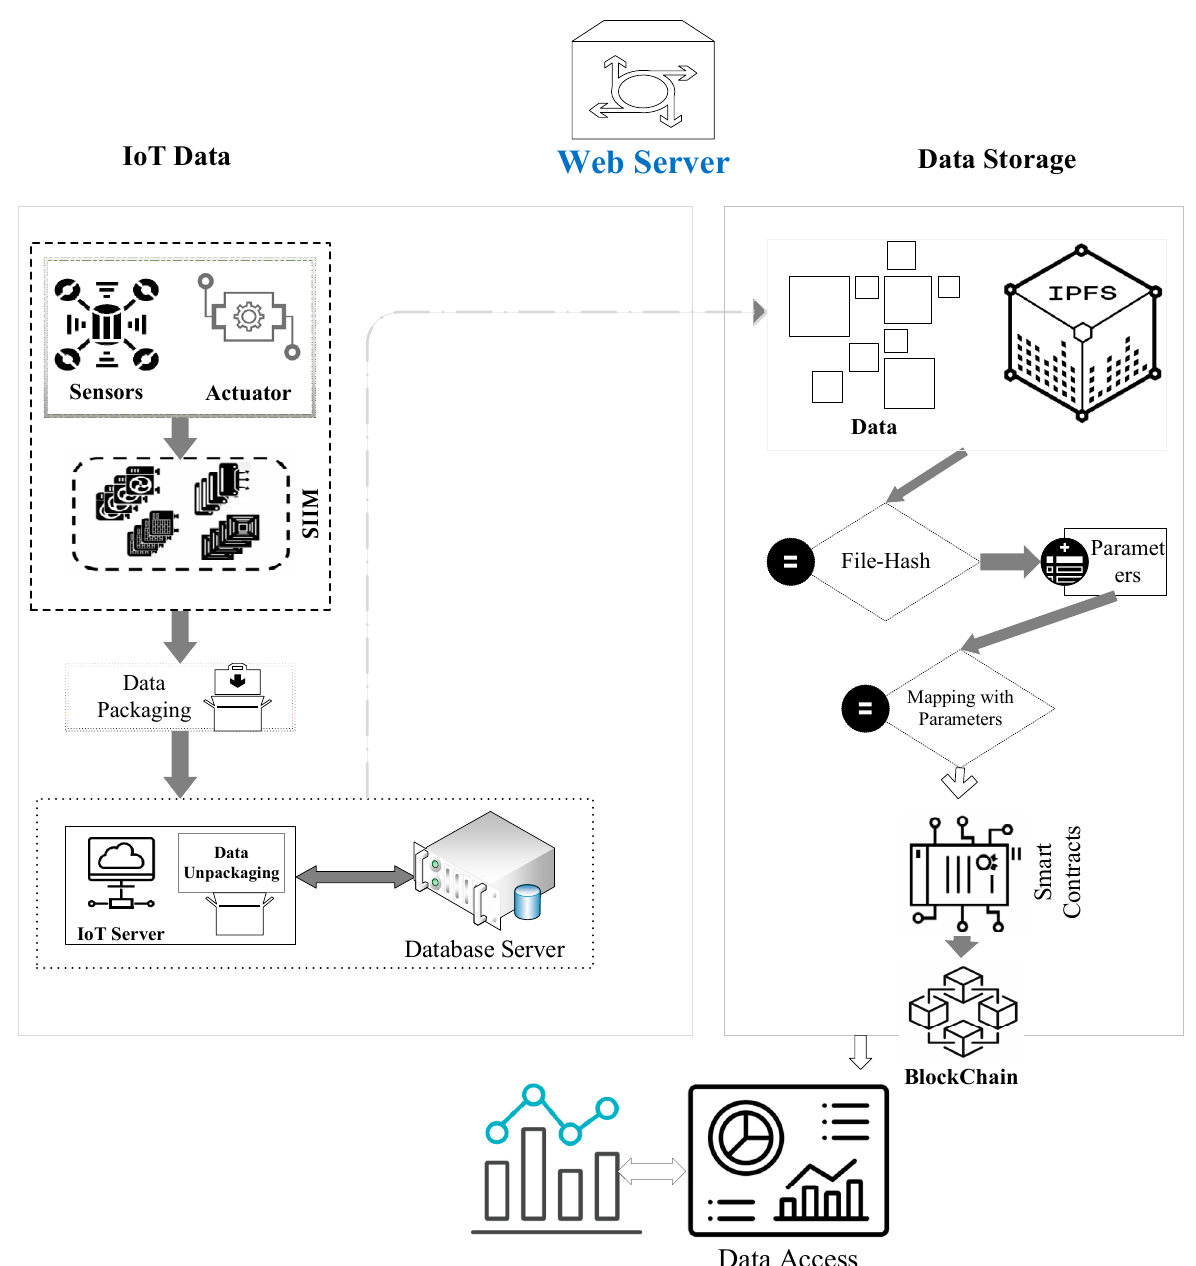
Figure 5. Overview of the detailed solution. Algorithm 1 Contract Creating